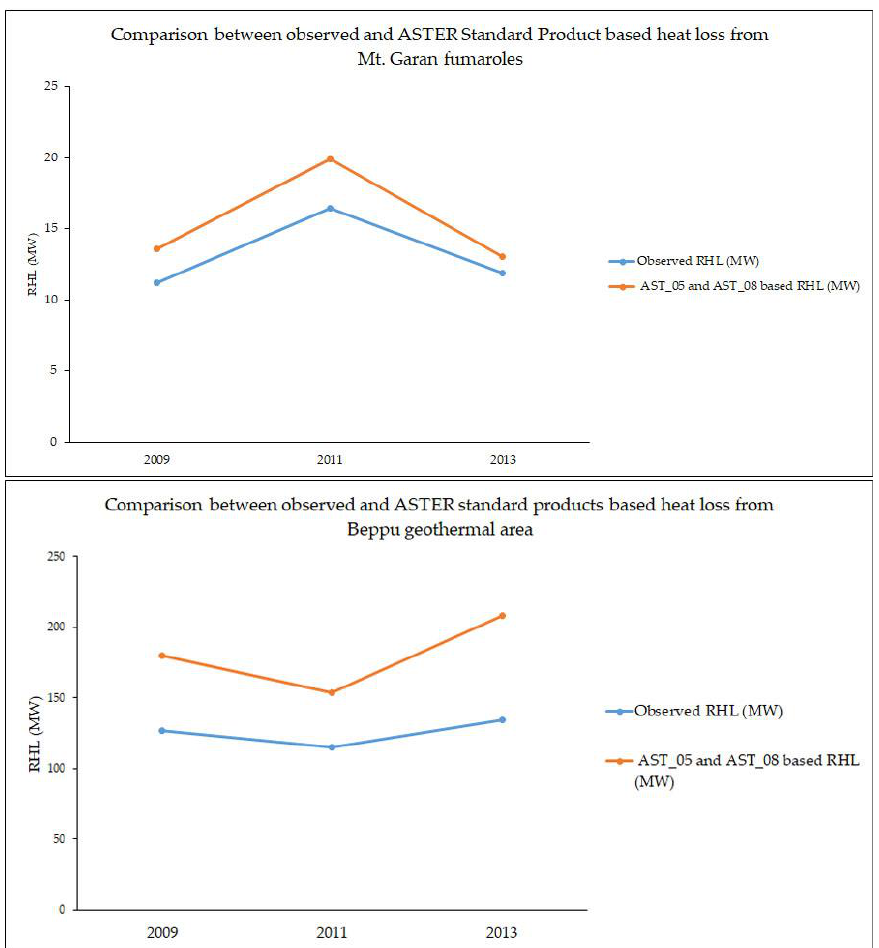
Figure 20. Comparison between observed and ASTER standard products base heat loss from the Mt. Garan fumaroles ( upper ) and Beppu geothermal area ( lower ).